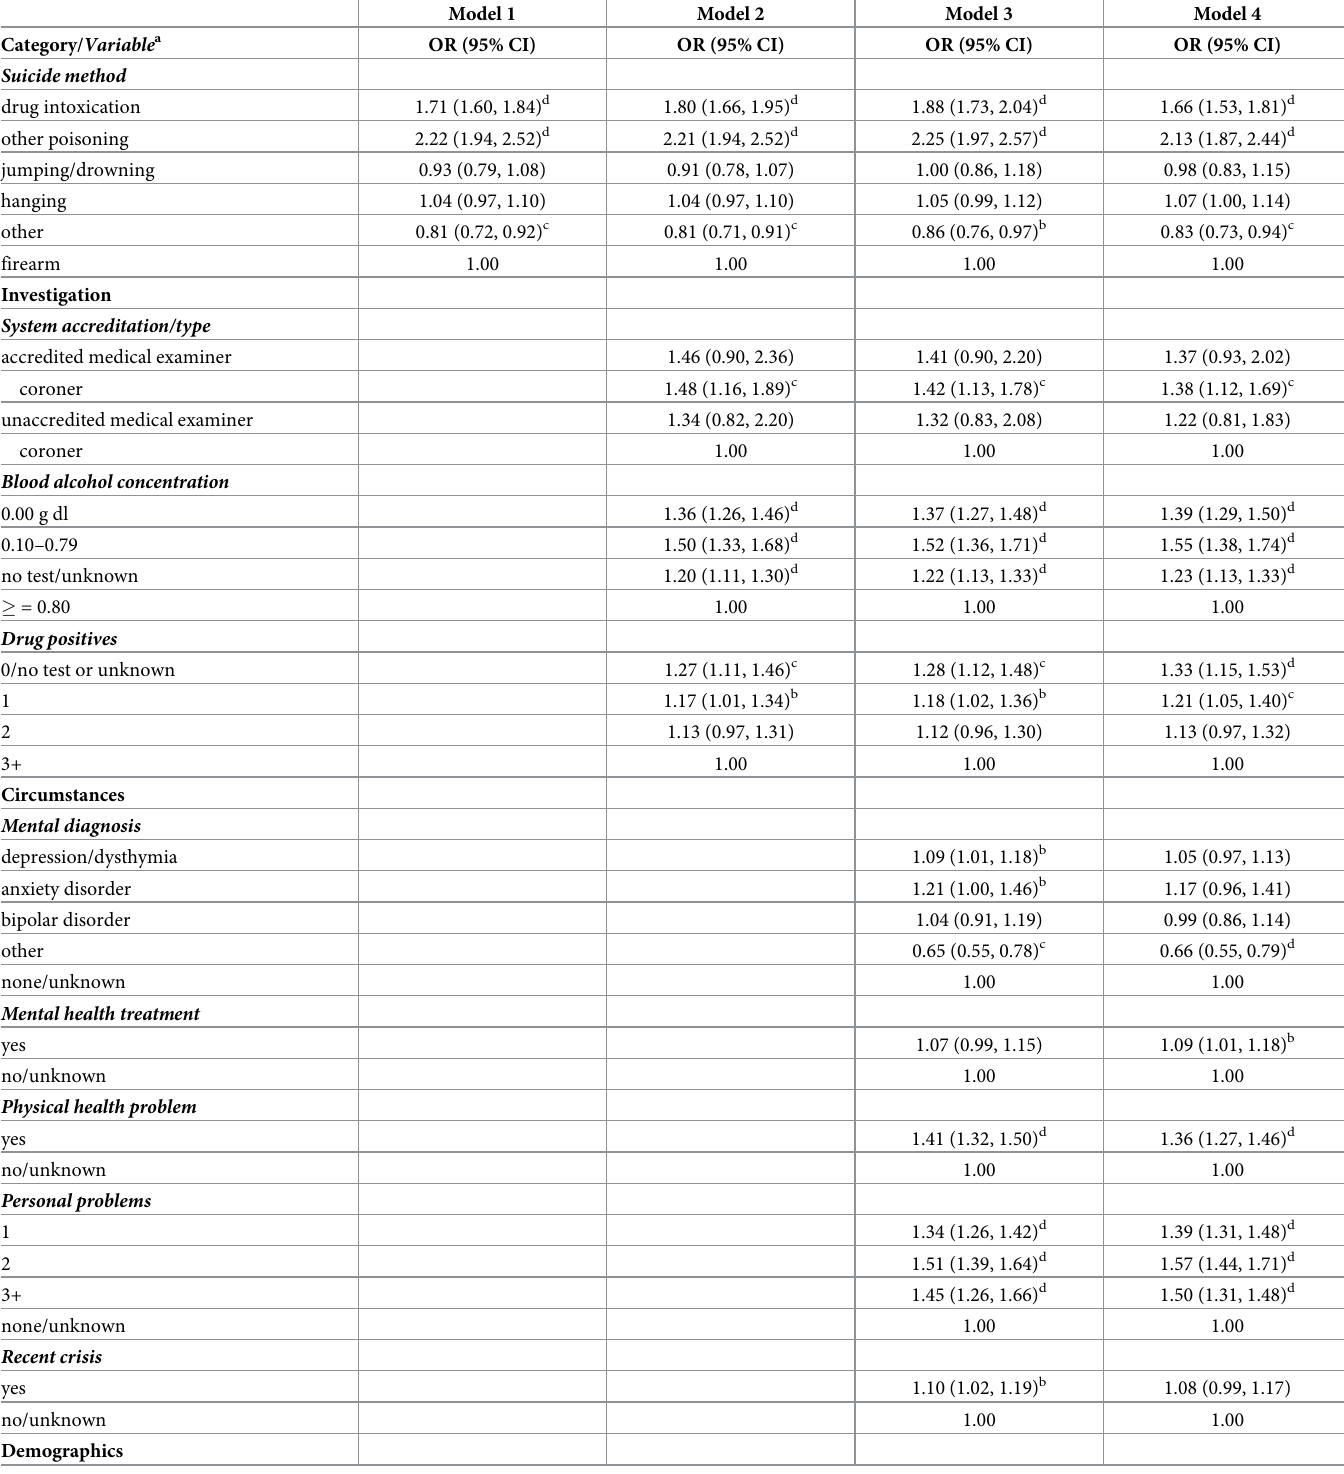
Table 3. Odds ratios and 95% confidence intervals for an evidentiary note by suicide method, cumulatively adjusted for investigation characteristics, death circum- stances, and demographics, 17 National Violent Death Reporting System States,